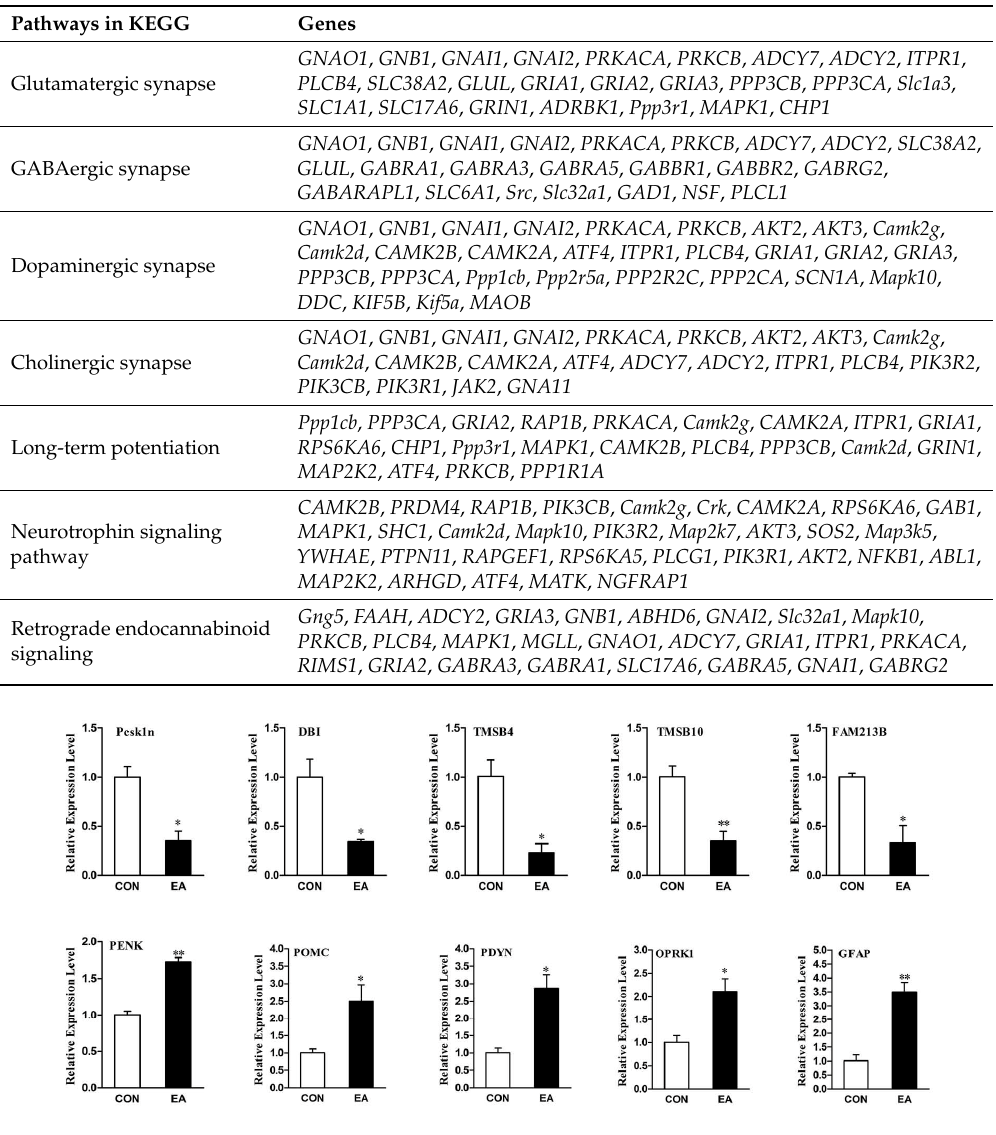
Table 3. DEGs in pathways of the nervous system.